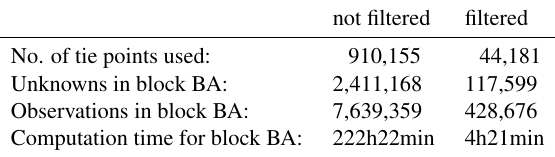
Table 2: Information about block adjustments of